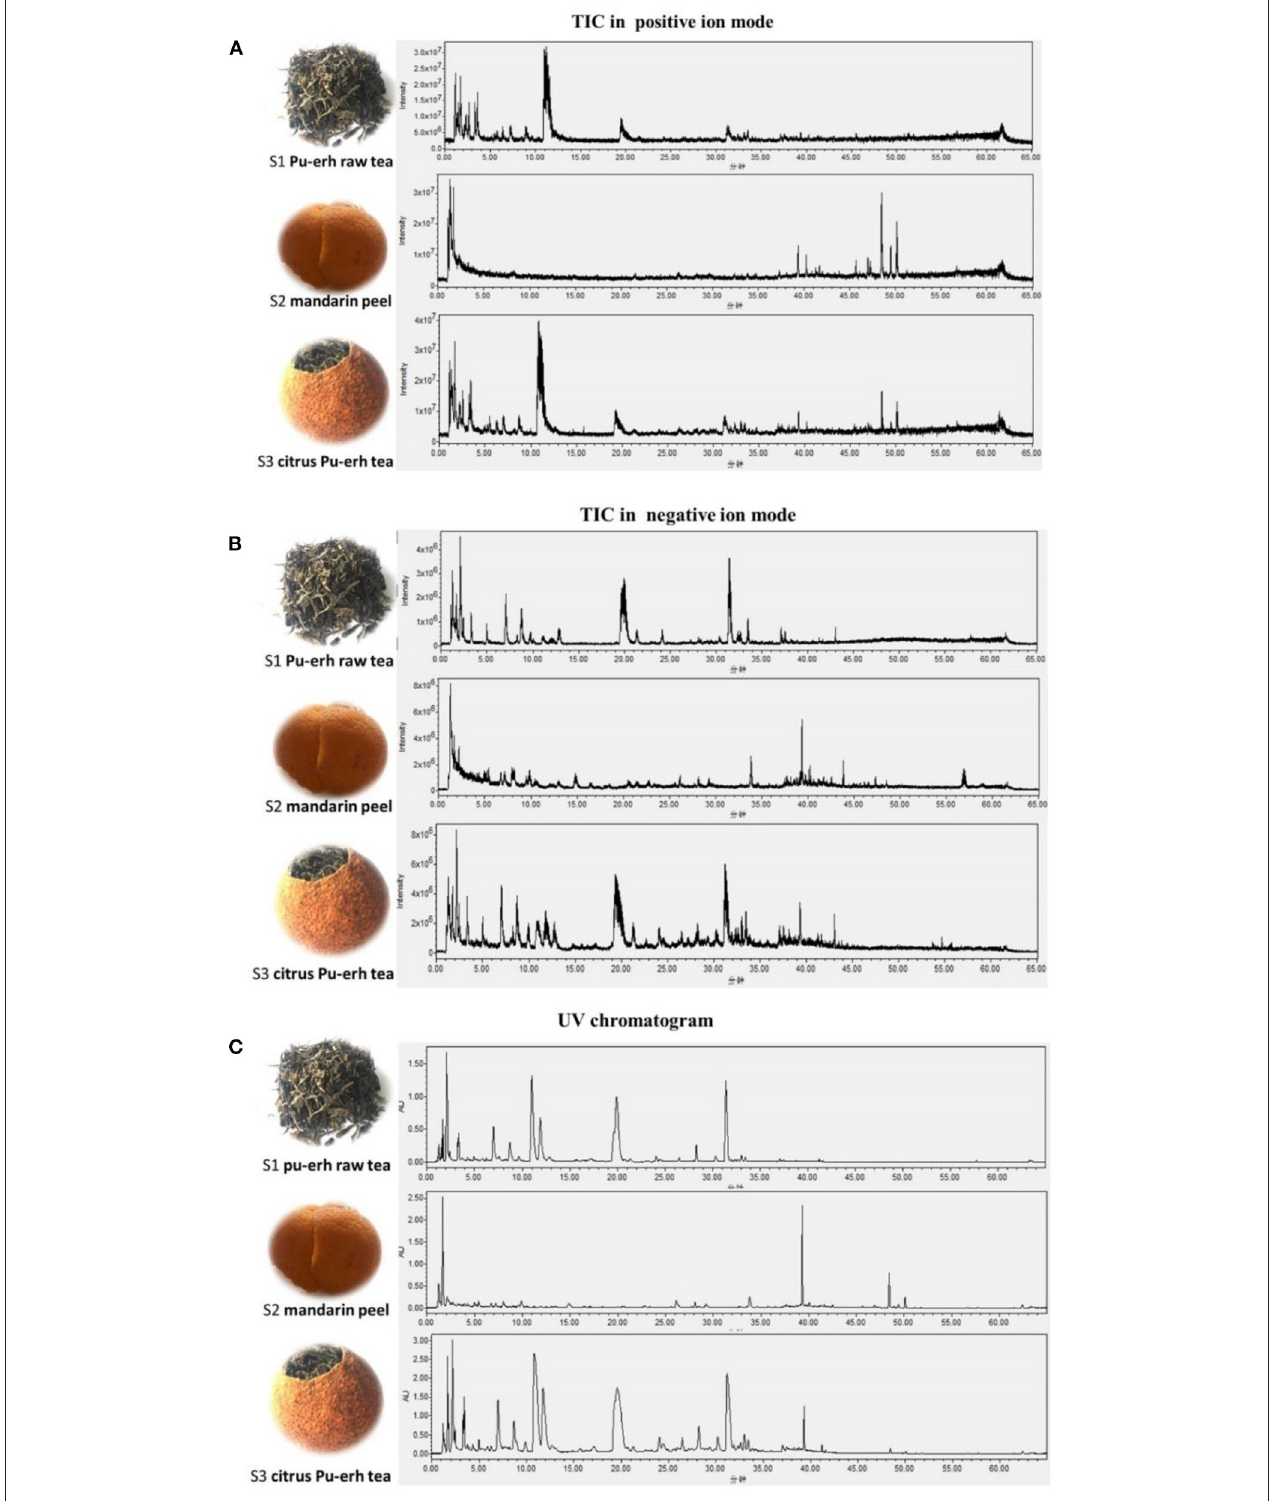
FIGURE 1 | Comparisons of the chemical compositions among Pu-erh raw tea, mandarin peel, and Ganpu tea by TIC in positive ion mode (A) , TIC in negative ion mode (B) , and UV chromatogram (C) , respectively. In our previous study, we investigated the source and conversion of aromatic substances of Ganpu tea. The fruity sweet aromas compounds of Ganpu tea were consisted of the main volatile components of Pu-erh raw tea and mandarin peel, in addition to the newly generated